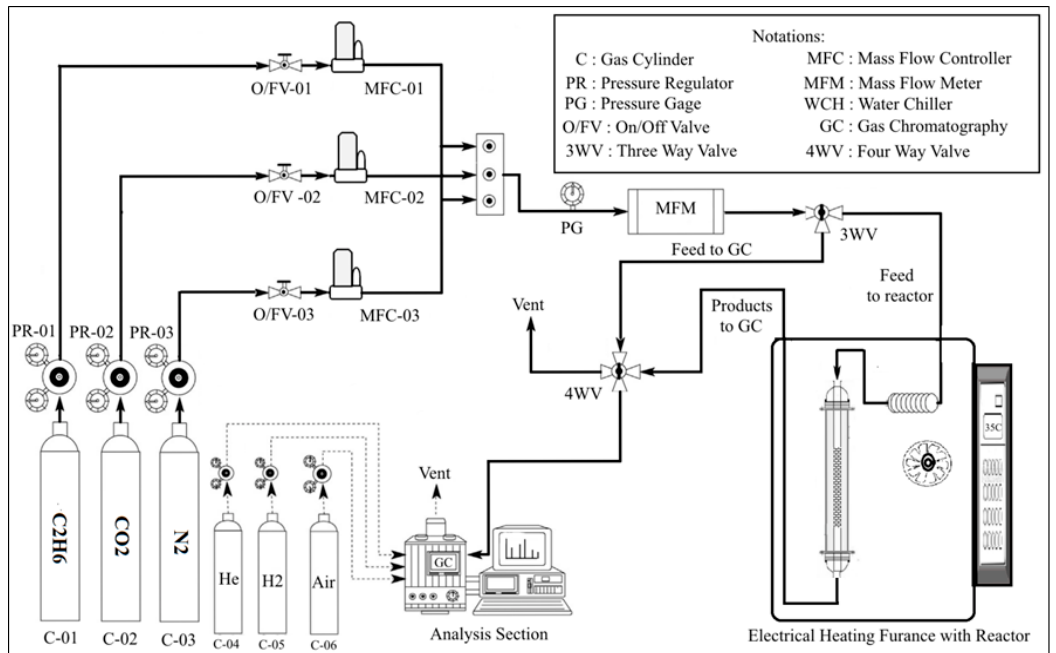
Figure 11. Experimental setup for the oxidative dehydrogenation (ODH) of C 2 H 6 with CO 2 .